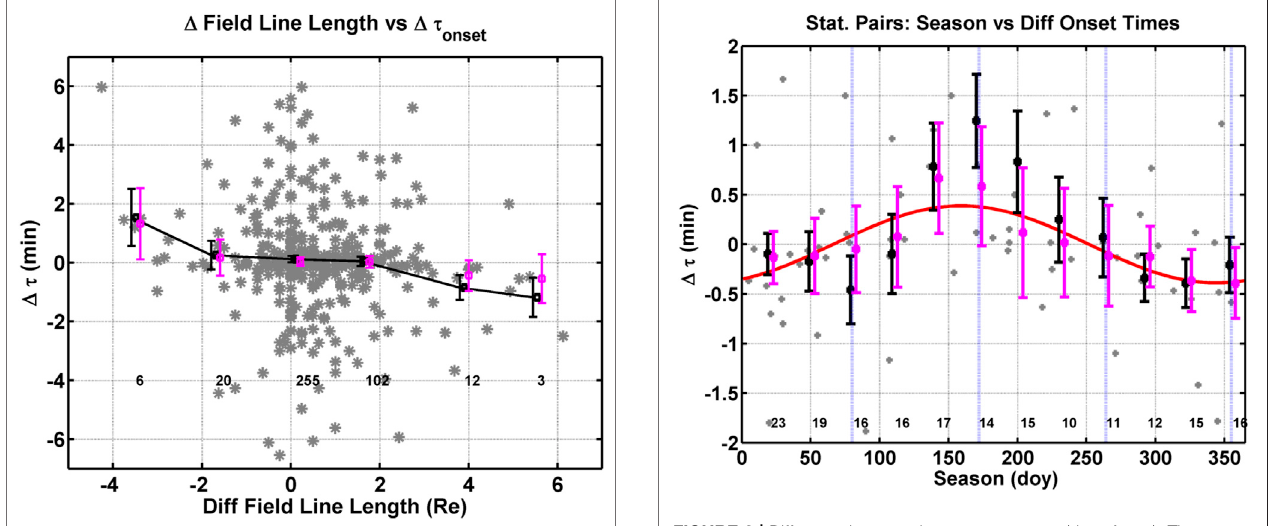
FIGURE 7 | Differences in onset time versus as a function of the difference in the magnetic fi eld line length (from the station to the central plasma sheet). The gray points are the individual events, the black points are meansofbins2Rewide,andthemauvepointsaremediansofbins2Re wide. The error bars are the error of the mean. The values at the base of the fi gure indicate the number points per bin.